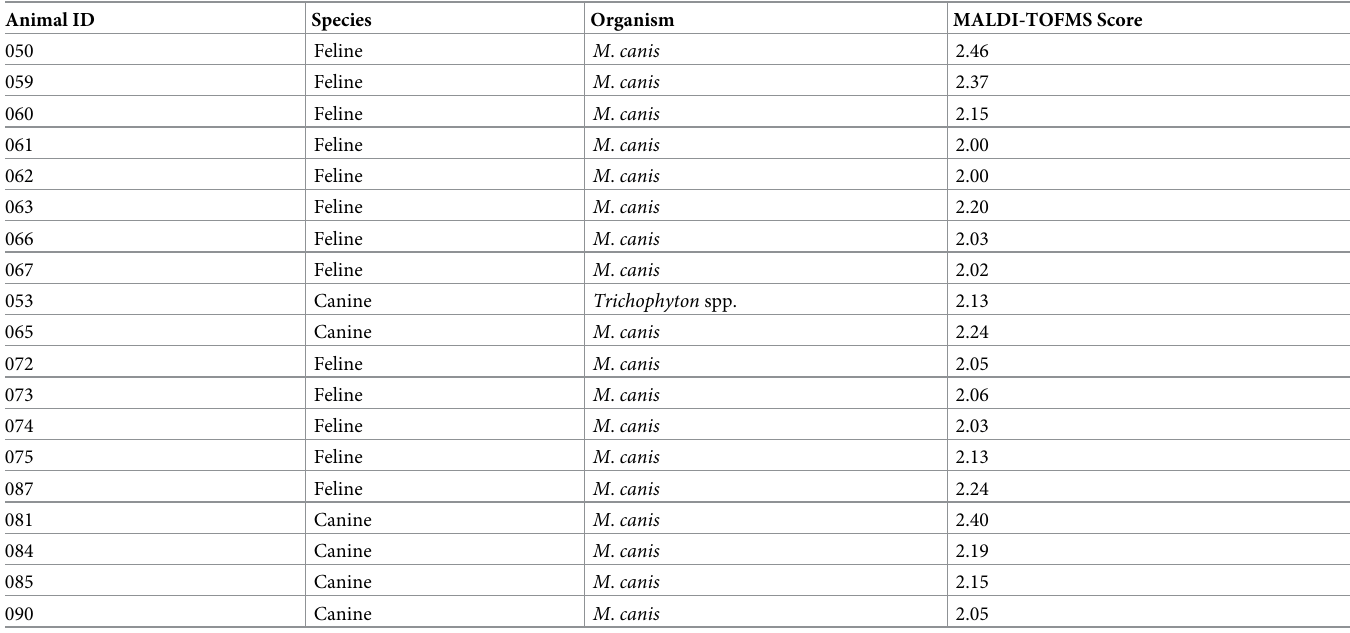
Table 2. Dermatophytes with their MALDI-TOF MS scores. Animal